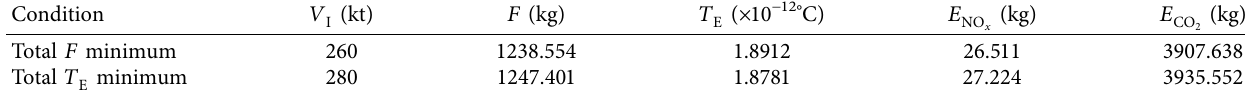
Table 2: Flight parameter variation with minimum fuel consumption and total temperature rise.